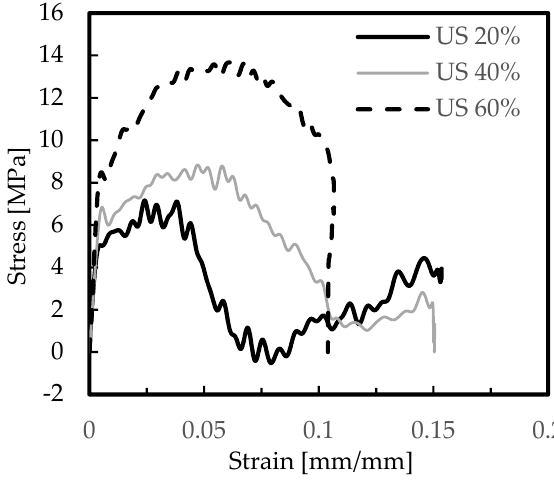
Figure 7. Stress-strain curves for the AlSi12 foams. Table 5. Results for the AlSi12 foams and US and the different nominal relative densities.